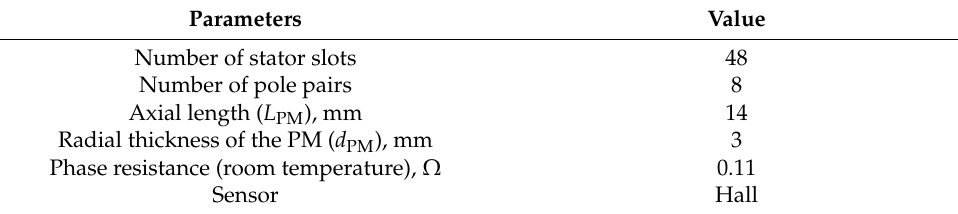
Figure 10. Structure of the BLDCM. Table 8. Main parameters of the BLDCM.